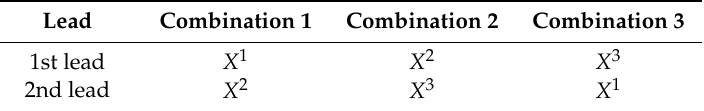
Table 3. The specific allocation results.